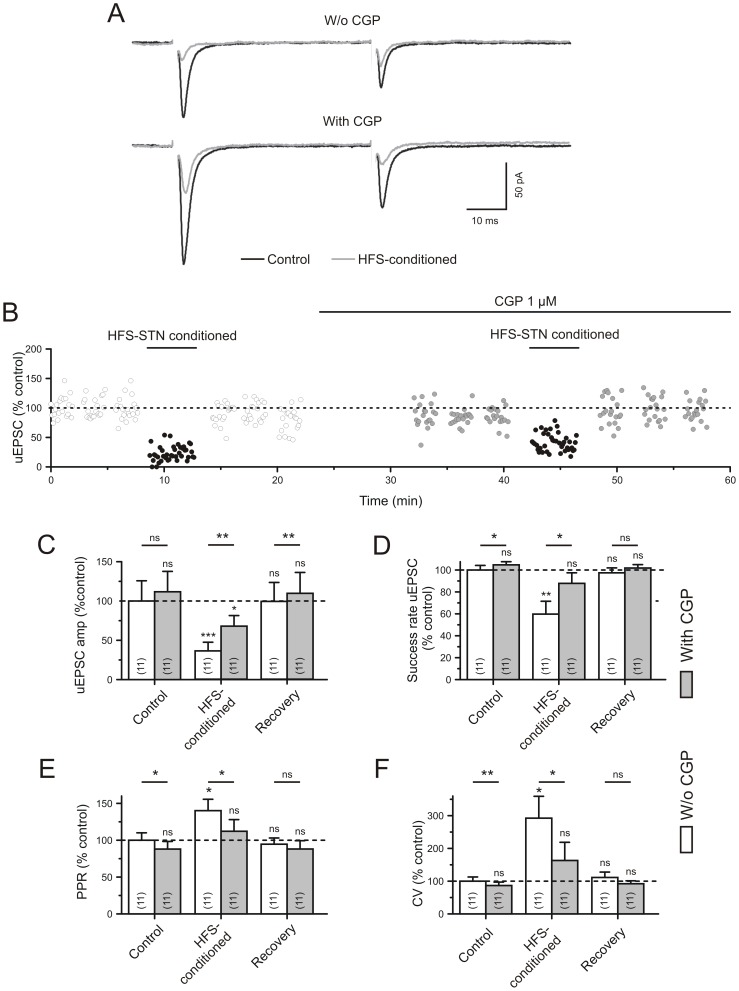
Block of GABA(B) receptors prevents the depressant effect of HFS-STN conditioning on unitary test responses induced by microstimulation of single STN axons in the SNr.A) Example traces to illustrate partial reversal of the HFS-STN effect on unitary EPSCs elicited with Microstim. Experiment in the presence of gabazine (15 µM). B) The plot of normalized uEPSC amplitudes against time of recording. The average value before the HFS trials is 100%. More than 10 min were allowed for the wash-in of the GABA(B) antagonist CGP55845 (1 µM). Note the alleviation of amplitude depression (B,C) and the increase in the success rate (D) in the presence of the GABA(B) blocker CGP55845. E,F) Quantification of the presynaptic parameters PPR and CV. The bars above the empty and shaded columns refer to the results of paired t-test. The asterisks above each column indicate significance levels from comparison with the Control, as tested with ANOVA. The differences between Control and respective Recovery values were not significant and are omitted in the graphs, for clarity.